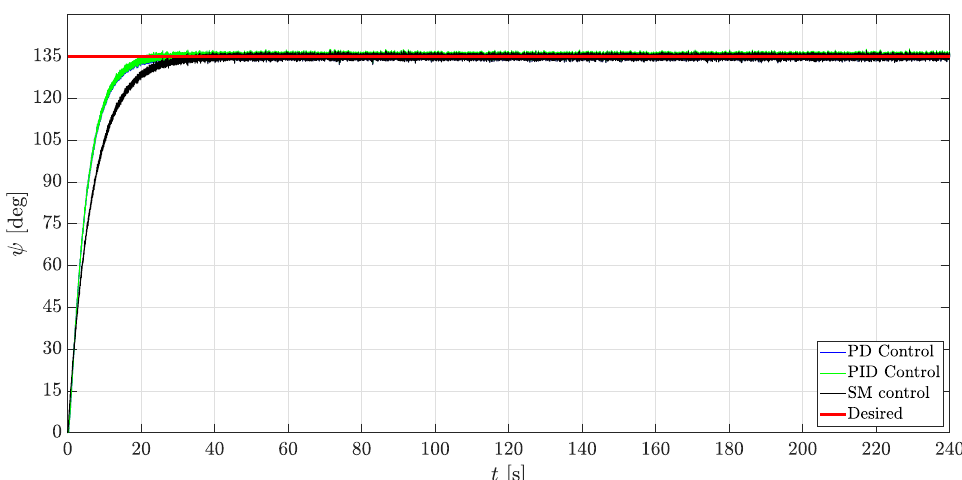
Figure 16. Rotational behavior of the mini-AUV about the axis I z ( ψ motion).